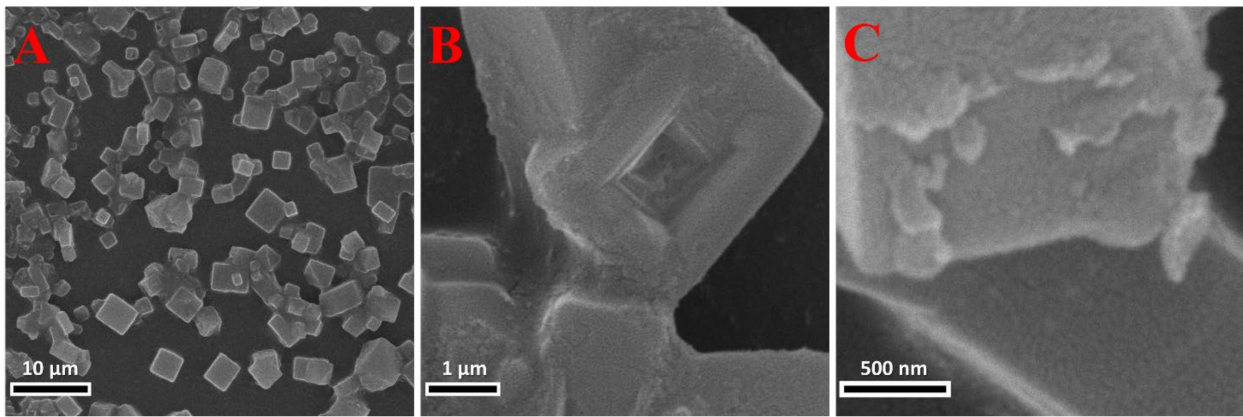
Figure 3. ( A – C ) are SEM images of the prepared sample with different scale bars and